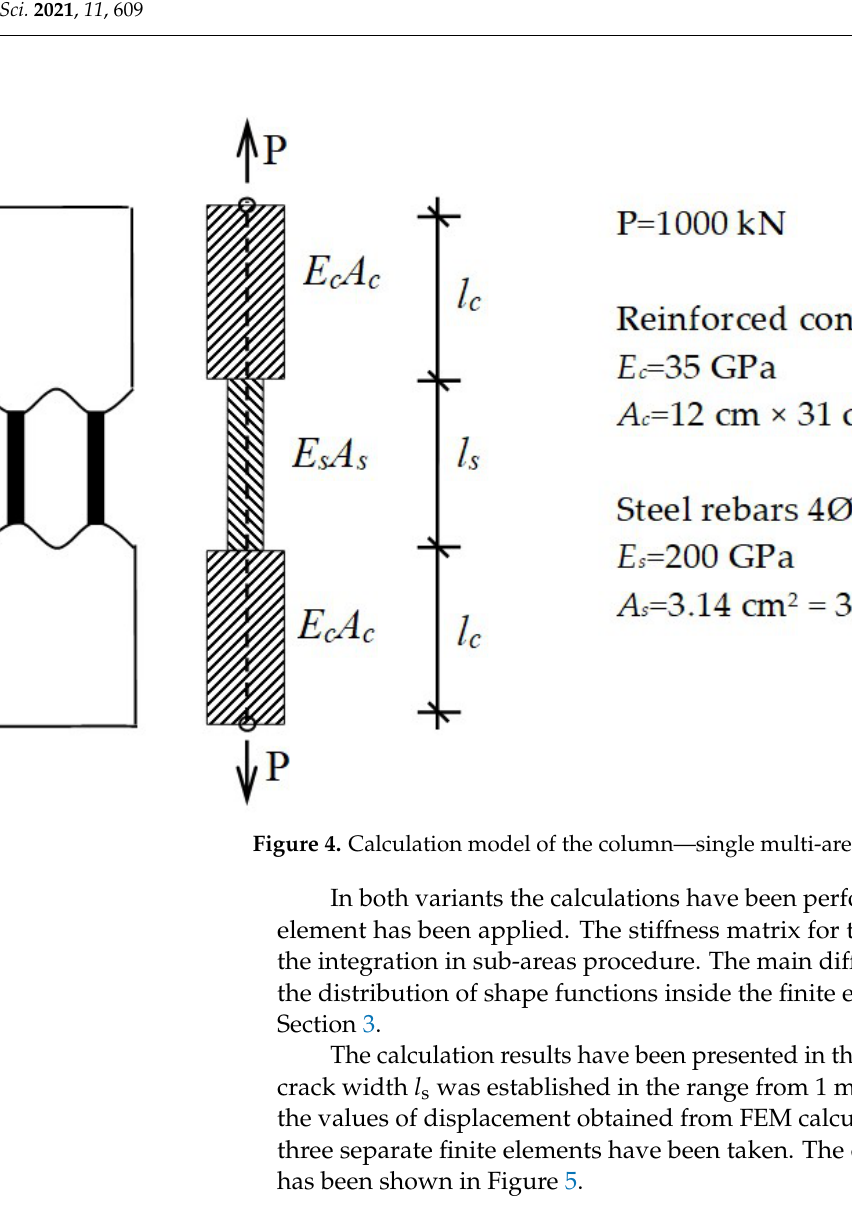
Table 1. Comparison of the displacement values [mm], Figure